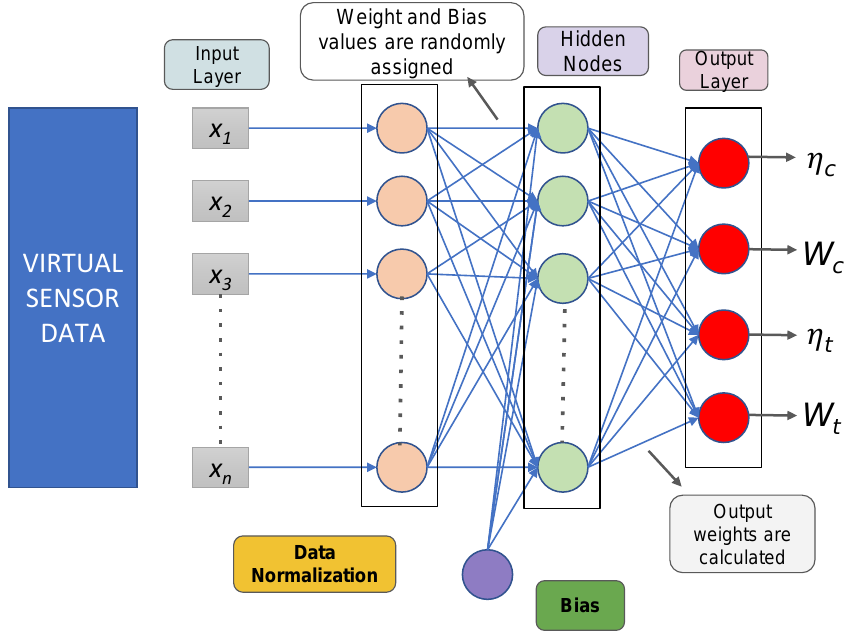
Figure 4. Structure of the ELM